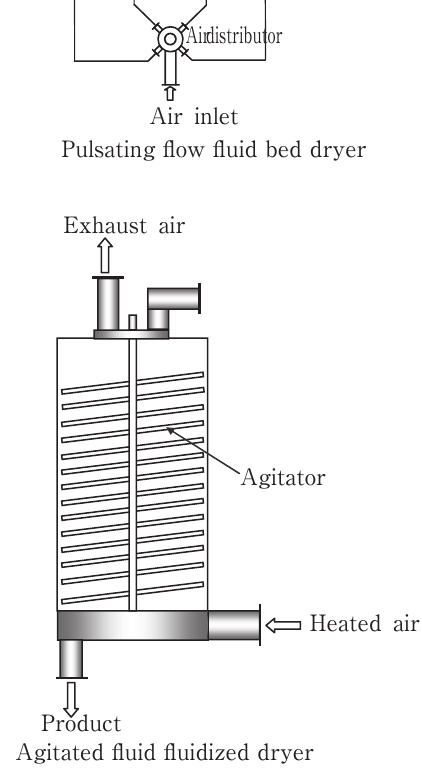
Fig. 5 Schematics of selected fluid bed dryer